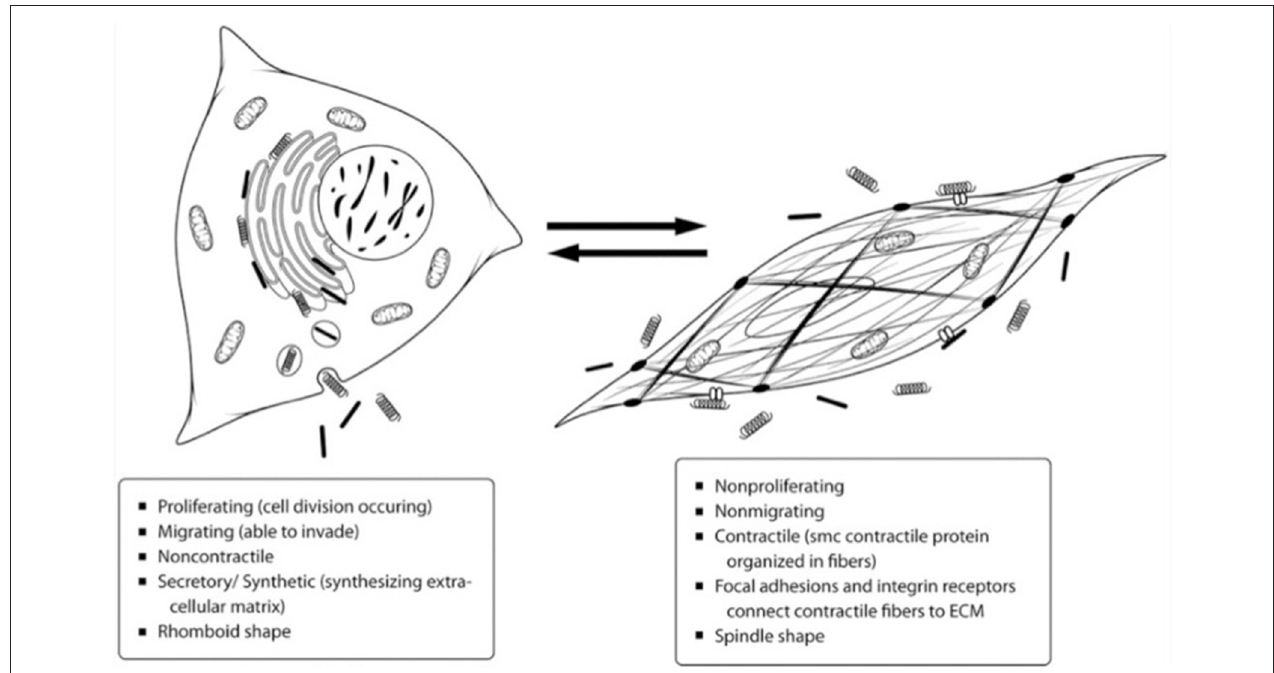
FIGURE 1 | Depiction of the differences between the contractile and synthetic VSMC phenotypes. Most VSMCs exist in the contractile state on the right to maintain blood pressure, but they can dedifferentiate into the synthetic phenotype on the left as necessary for proliferation and tissue repair